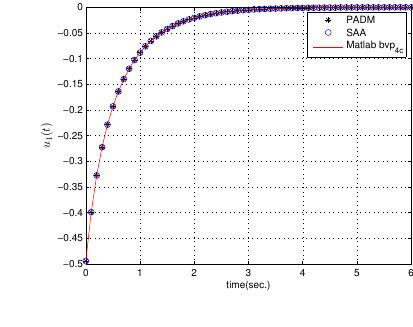
Figure 7. The optimal control function u 1 ( t